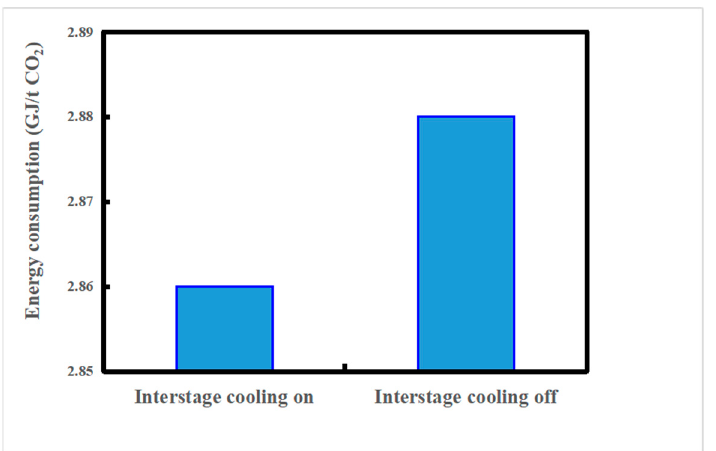
Figure 10. Effect of interstage cooling on the regeneration energy consumption. The steam con- sumption is 60 kg/h, liquid–gas ratio is 1.82 L/m 3 , regeneration pressure is 191 kPa, and rich liquid fractional flow ratio is 29%.